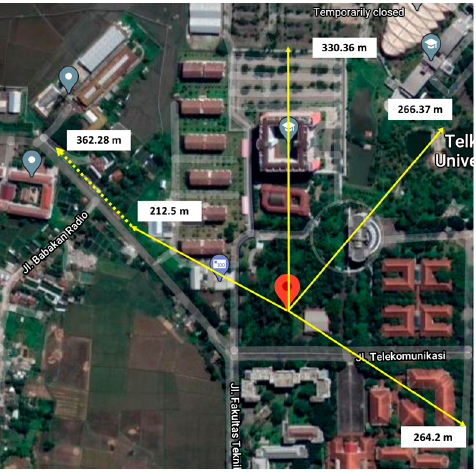
Figure 13. Non-LoS Tracking Scenario at Small Forest inside Telkom University Area. Figure 13. Non - LoS Tracking Scenario at Small Forest inside Telkom University Area. Table 3. Test Result Tracking of Proposed System at N-LoS Location (Small Forest).